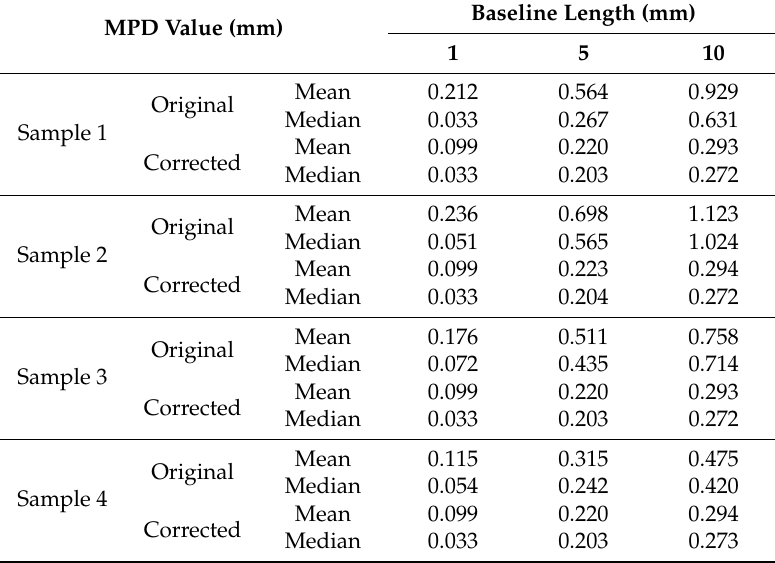
Table 3. Mean and median MPD values from the original and corrected